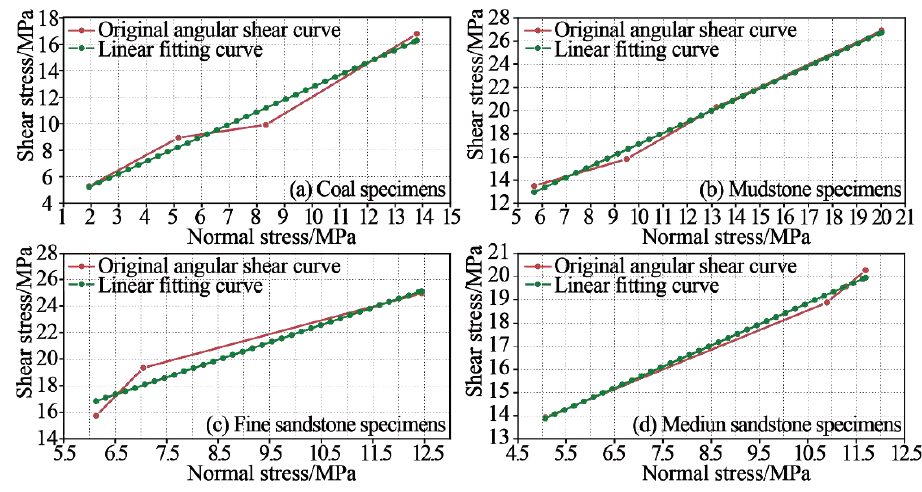
Figure 7. Coal rock variable angle shear specimen.